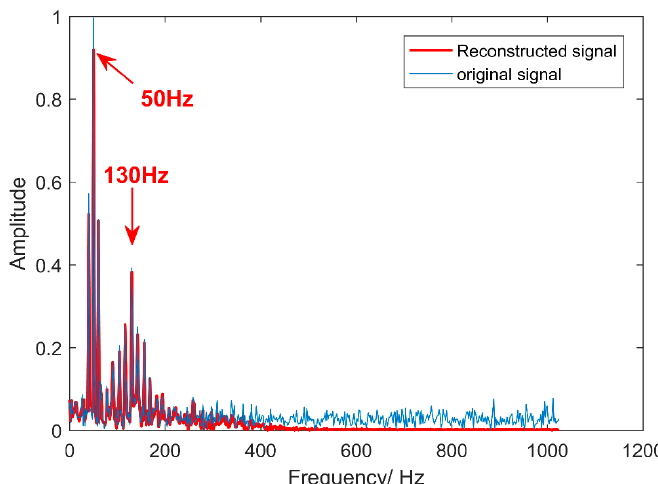
Figure 9. Comparison of the original signal and reconstructed signal.